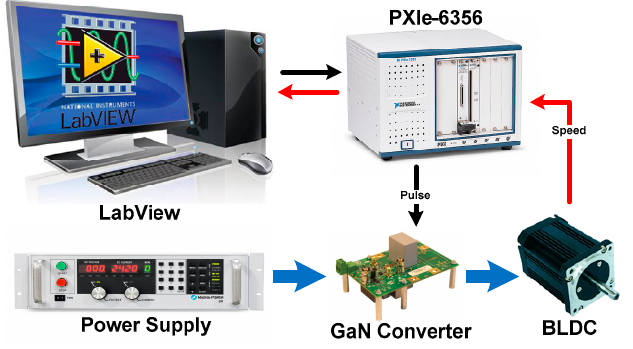
Figure 1. System configuration.